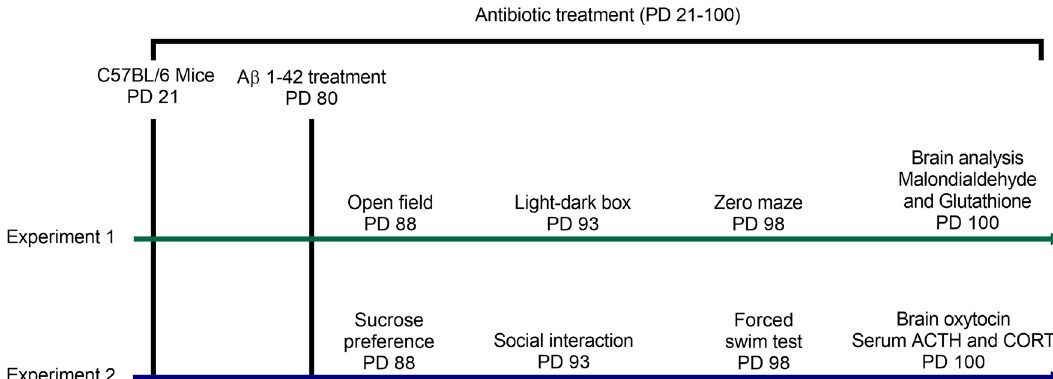
Figure 9. Schematic timeline of the experimental